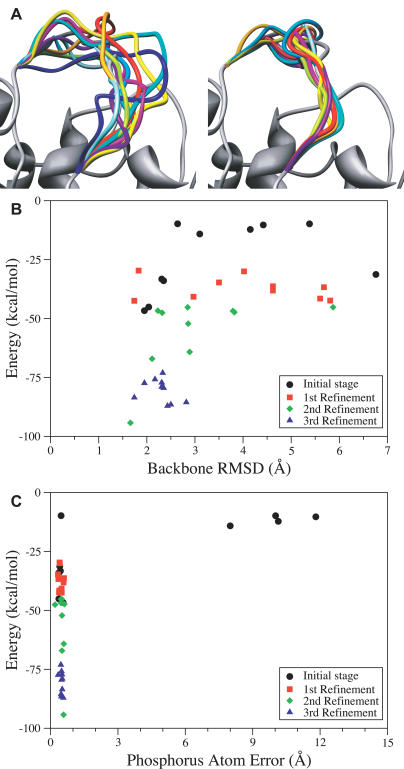
Example of the Hierarchical Loop Prediction, Applied to Reconstructing the Phosphorylated Activation Loop of CDK2/Cyclin AIn this example, only the loop is predicted, and the remainder of the protein is held rigid in its crystallographic conformation.(A) Backbone traces for the ten lowest-energy loops sampled in the initial build-up stage (left) and the third and final refinement stage (right) of the hierarchical loop prediction protocol (figures prepared with Chimera [72]).(B) Energies as a function of backbone RMSD values of the 20 lowest-energy loops sampled in the four stages of the loop prediction protocol.(C) Energies as a function of the error in the phosphorus atom position, relative to the crystal structure, for the 20 lowest-energy loops sampled in the four stages of the loop prediction protocol.